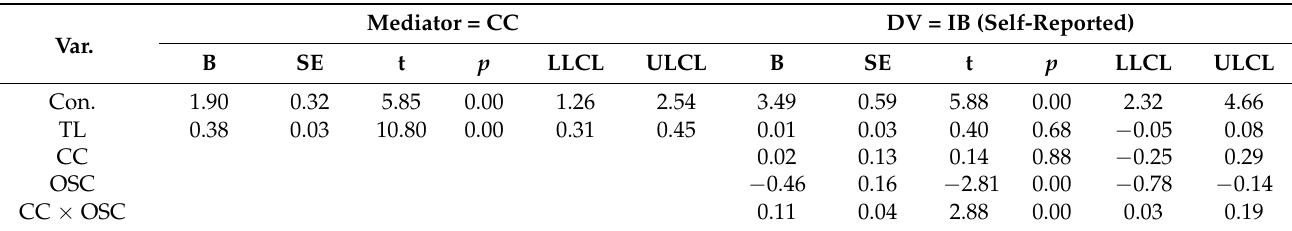
Table 5. Regression analyses of IB (self-reported) for the mediator and